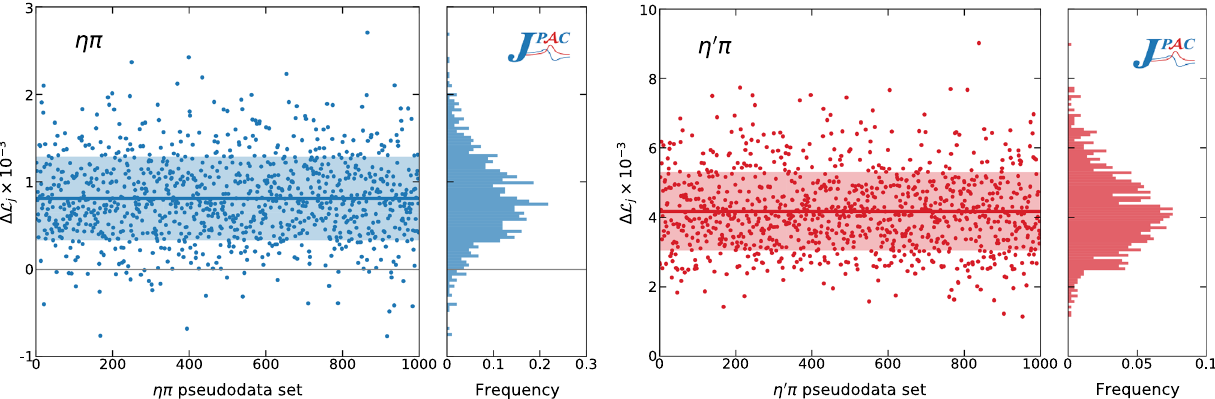
Fig. 28 Extended negative log-likelihood difference (cid:18) L j = ( MIN + f / IP ) − L ( MIN + IP / IP ) for 10 3 MCR ηπ (left, blue) η (cid:2) π L j j (right, red) resamples. The colored line is the mean of the distribution and the band represents the 68% confidence level. While for η (cid:2) π the